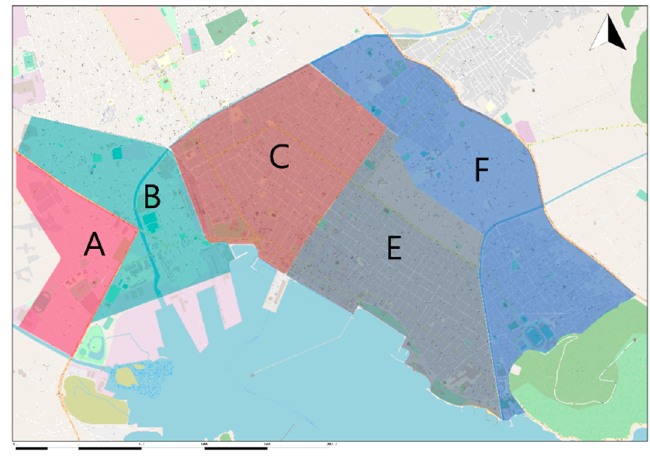
Figure 3. The sub-areas of the city of Volos selected for the placement of the sensors.